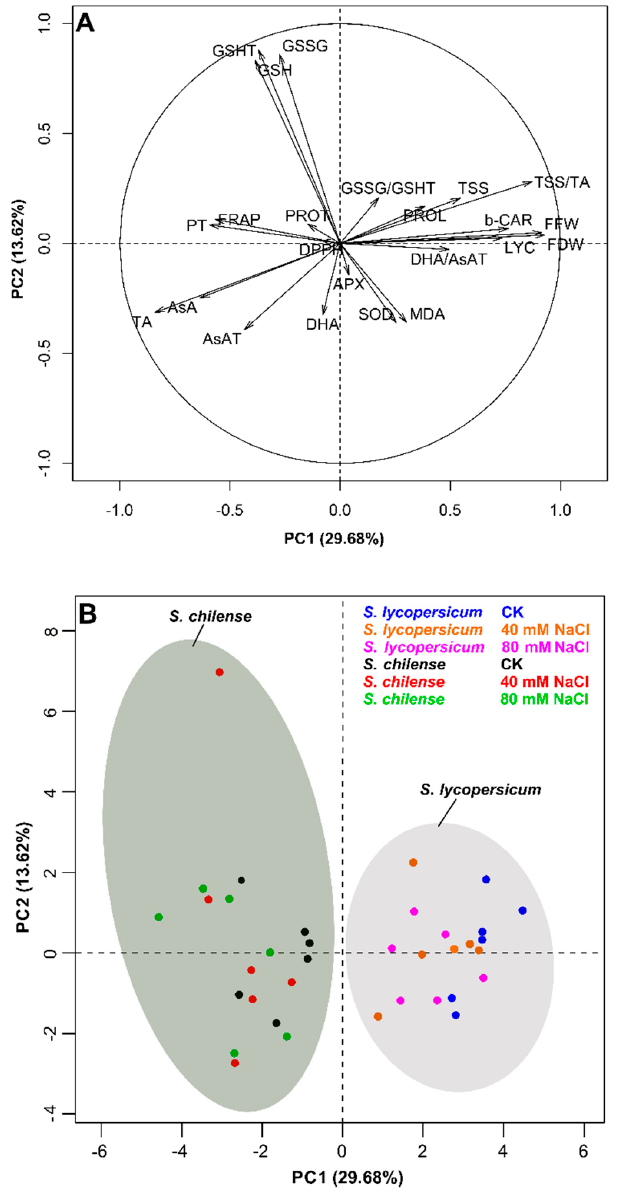
Figure 5. Principal components analysis (PCA) of the bioactive compounds, capacity antioxidant and fruit quality at the harvest for cultivated Solanum lycopersicum and wild-relative S. chilense under control (CK) and saline conditions ( A , B ). Individual graphs showing the mean values per each species. Abbreviations are explained as follows: APX: Ascorbate peroxidase; AsA: Total reduced